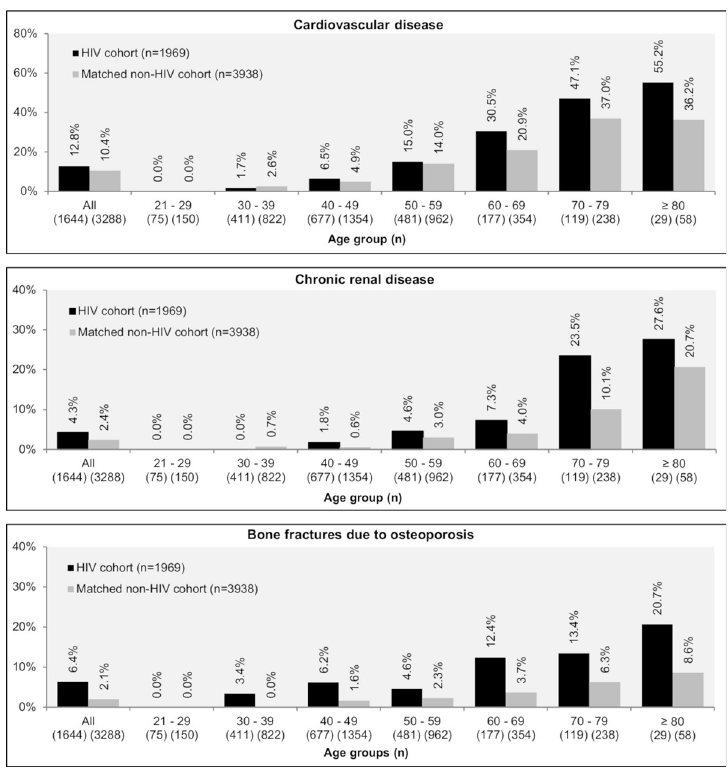
Fig 1. Prevalence of specific comorbidities stratified by age groups in PLHIV and a matched non-HIV cohort over the previous 2 months.